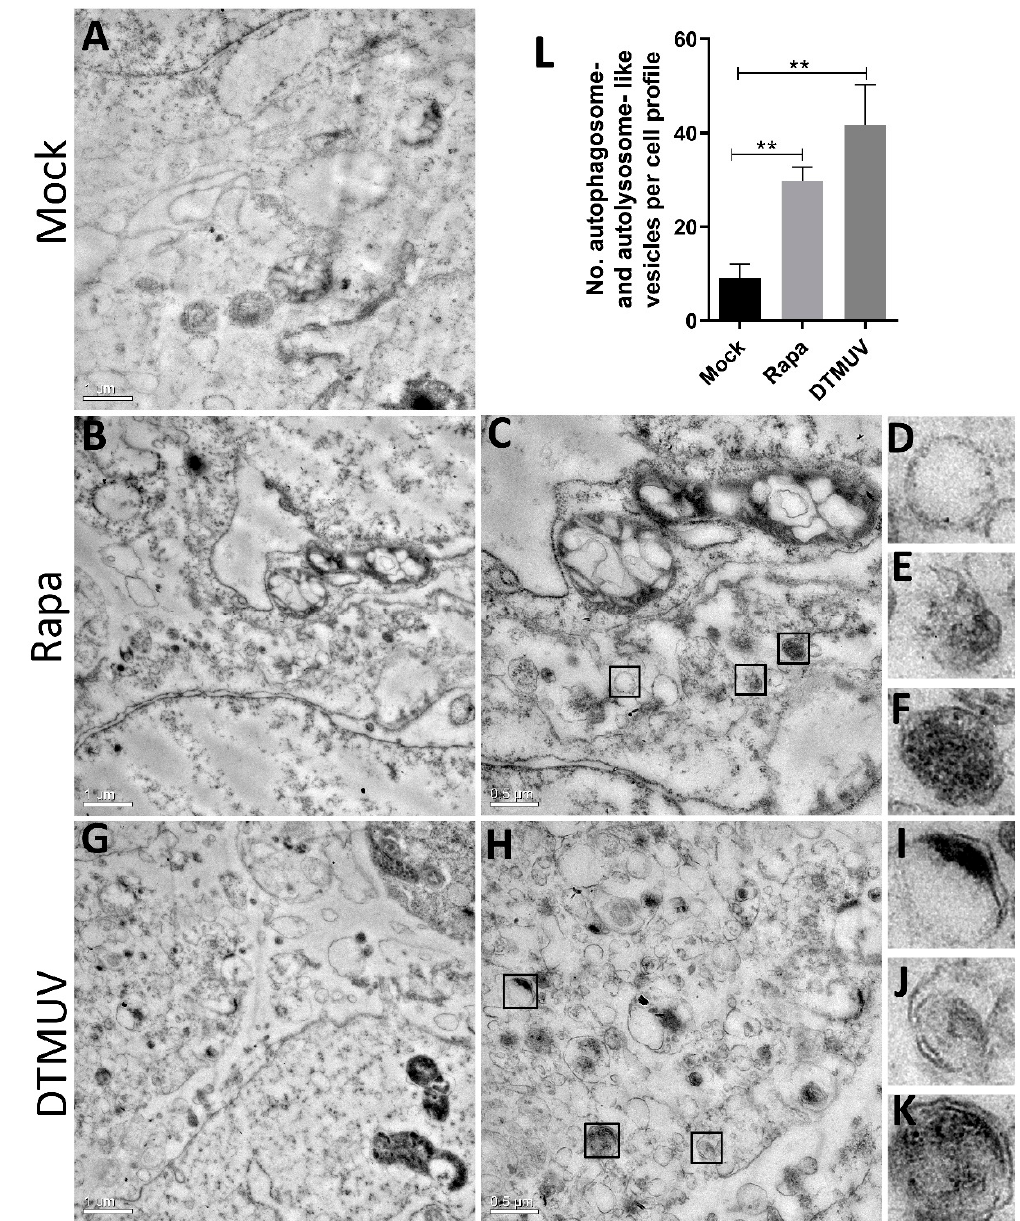
Figure 1. Observation of autophagy-like vesicle formation by TEM. ( A ) Duck embryo fibroblast (DEF) cells were mock-infected as a negative control. ( B – F ) DEF cells were treated with rapamycin (Rapa) (1 µ M) as a positive control. Panel ( C ) was a higher-magnification view of panel ( B ). Panels ( D – F ) were further enlargements of mature autophagosome-like, immature autophagosome-like, and autolysosome-like vesicles, respectively. ( G – K ) Duck embryo fibroblast (DEF) cells were infected with DTMUV CQW1 at a multiplicity of infection (MOI) of 1 for 36 h. Panel H was a higher-magnification view of panel ( G ). Panels ( I – K ) were further enlargements of immature autophagosome-like, mature autophagosome-like, and autolysosome-like vesicles respectively. ( L ) Quantification of the number of autophagosome-like and autolysosome-like vesicles per cell profile in mock-infected, Rapa-treated, and Duck Tembusu virus (DTMUV)-infected DEF cells. Average number in each cell profile was obtained from 10 cell profiles undergoing each treatment. The data are represented as the mean ± SD from three independent experiments. Two-tailed Student’s t test, ** p < 0.01.